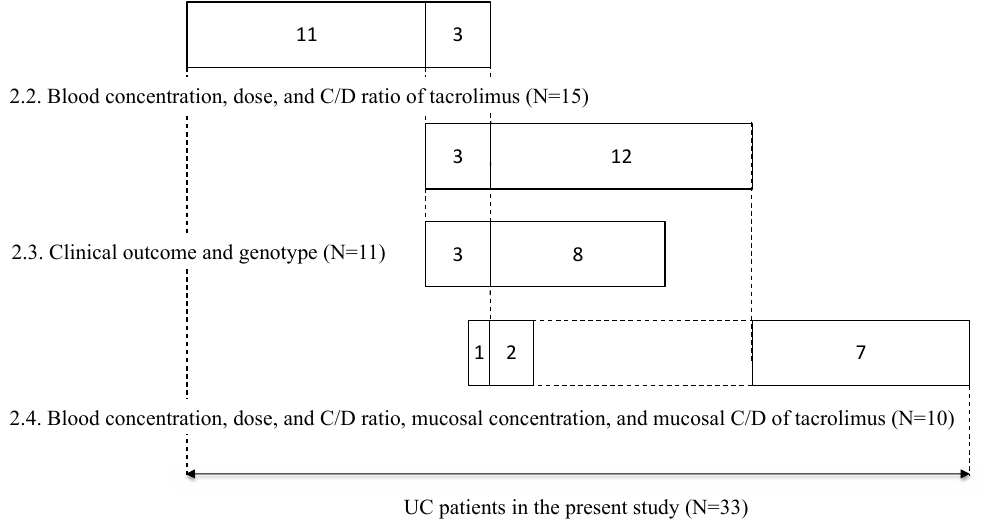
Figure 7. Summary of subjects enrolled in this study. The numbers in each box reflect the number of subjects. The numbers in each line correspond to each subsection of the results section, respectively.